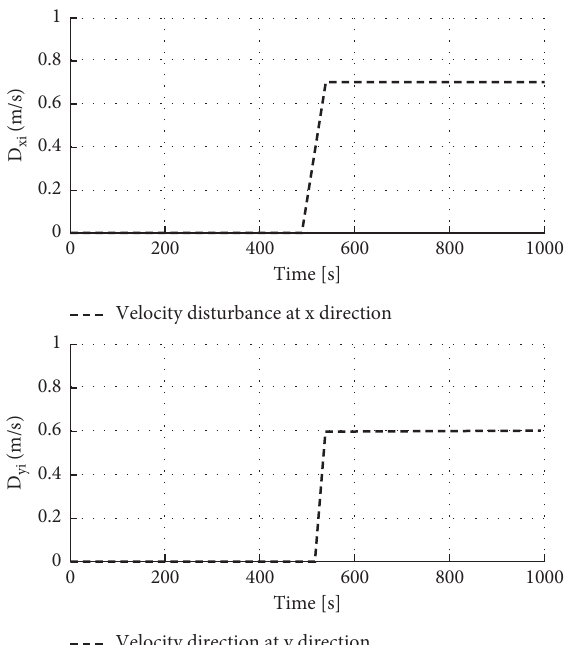
Figure 11: X and Y velocity components of disturbance.